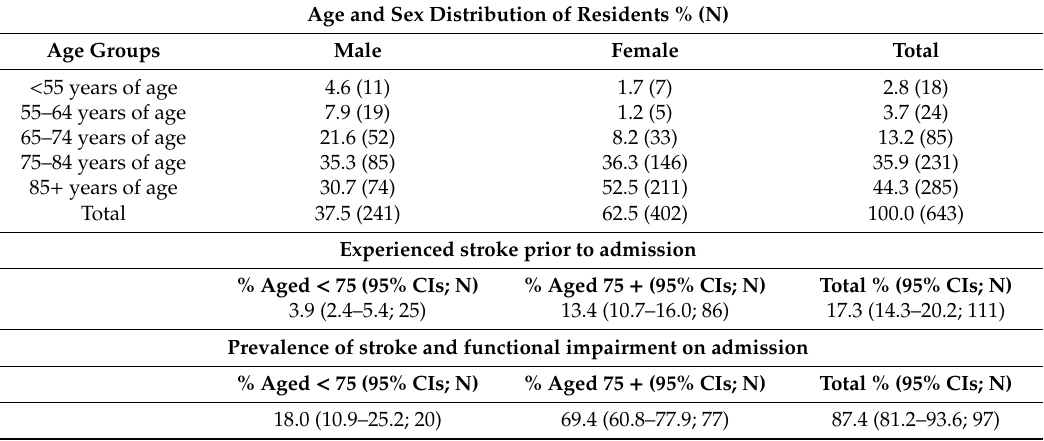
Table 1. Sample description.